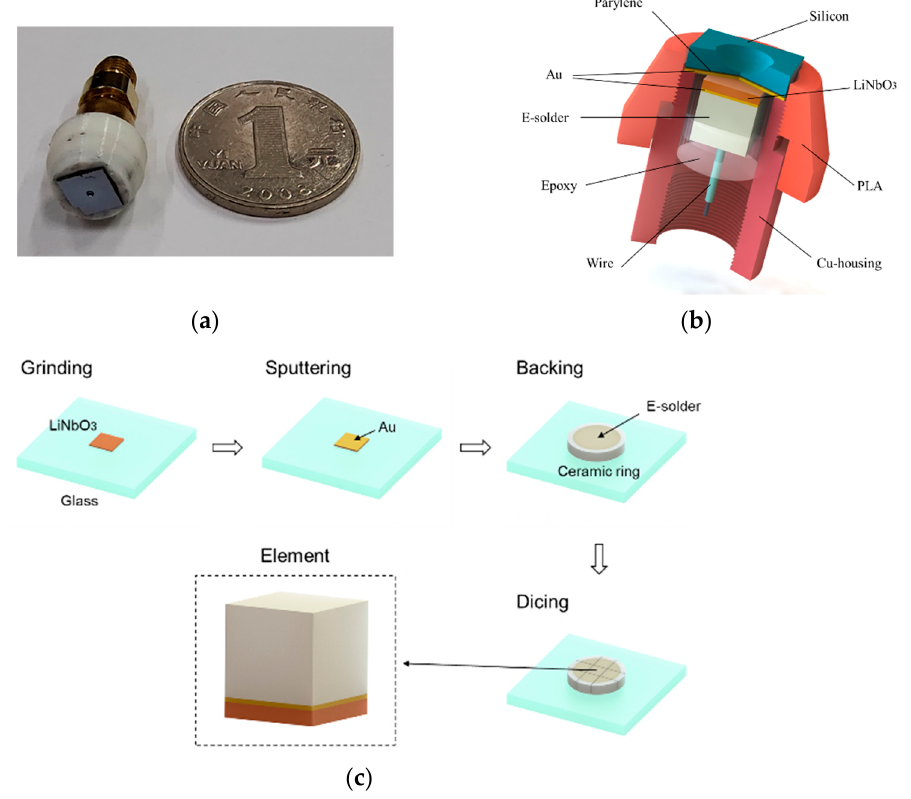
Figure 4. ( a ) The fabricated devices. ( b ) Schematic diagram of UHF ultrasound transducers. ( c ) The preparation processes of the elements.